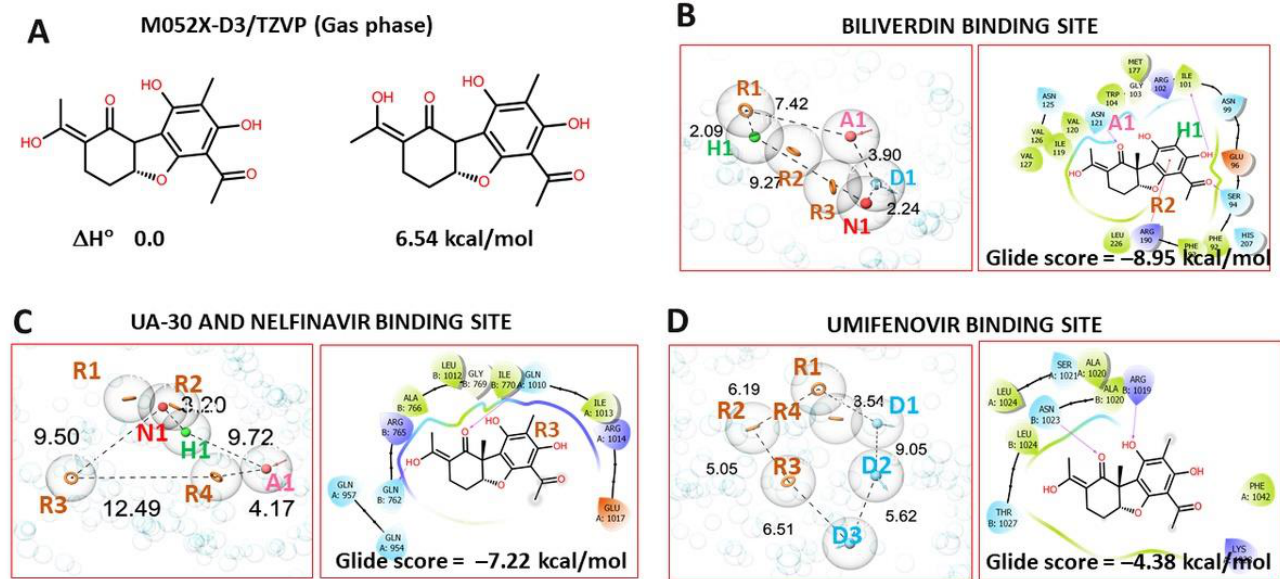
Figure 5. Results of quantum chemical calculations and molecular docking procedure agent 13 into probable binding sites: ( A )—two possible isomeric form E and Z of lead-compound 13 ; ( B – D )—the probable binding sites: A - two possible isomeric form E and Z of lead-compound 13; B,C,D - the locations of 13 in bindig site of locations of 13 in bindig site of S-protein.